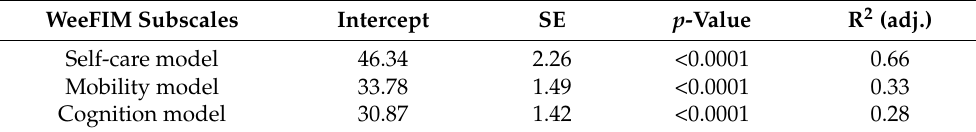
Figure 2. Mean score of the items composing each WeeFIM subscale. Self-care items: Ea = eating; Gr = grooming; Ba = bathing; DU = dressing (upper); DL = dressing (lower); To = toileting; Bl = bladder; Bo = bowel. Mobility items: ChT = bed, chair, wheelchair transfer; ToT = toilet transfer; TuT = tub/shower transfer; WC = walk/wheelchair; St = stairs. Cognition: Co = comprehension; Ex = expression; SI = social interaction; PS = problem solving; Me = memory. Error bars represent 1 SE. Values below the upper dotted line indicate modified independence, while values below the lower dotted line indicate the need for supervision.